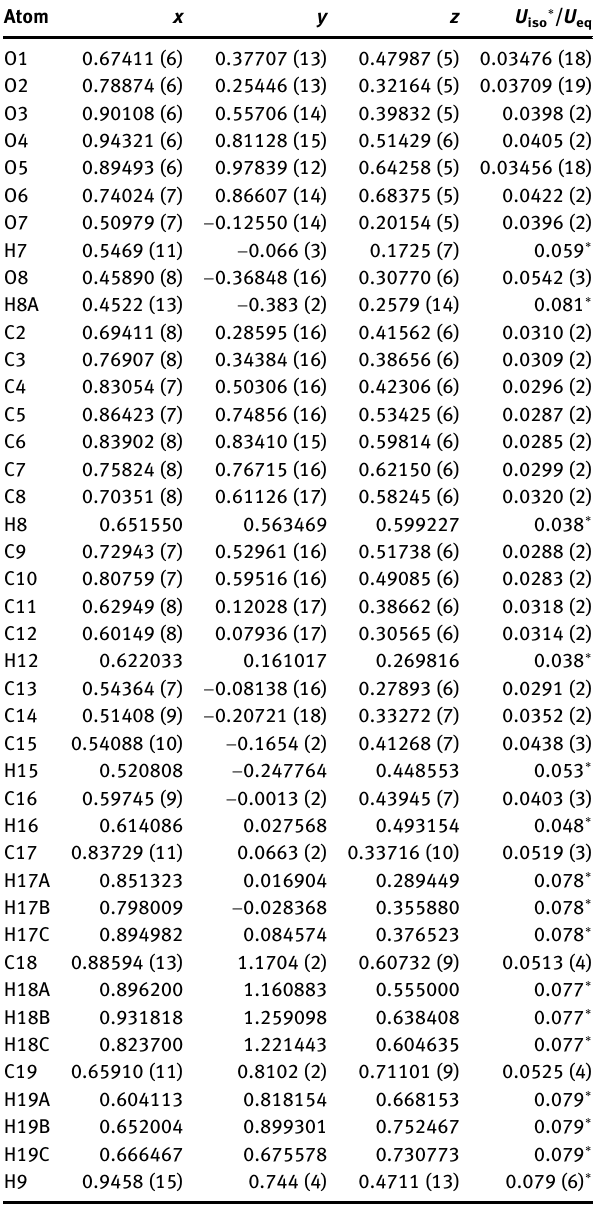
Table  : Fractional atomic coordinates and isotropic or equivalent isotropic displacement parameters (Å  ).